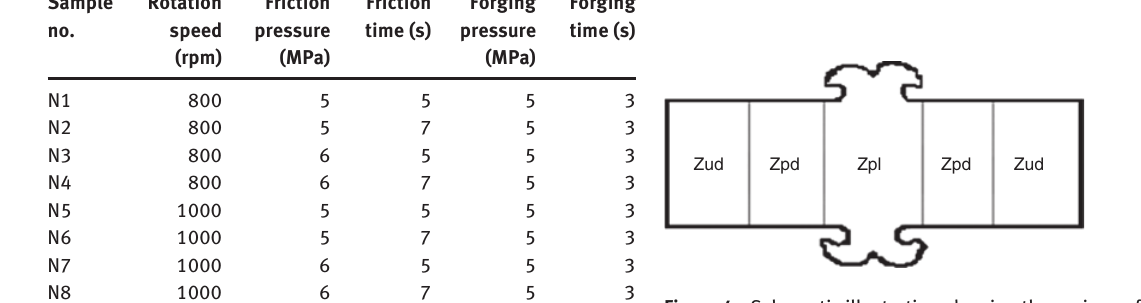
Figure 4 Schematic illustration showing the regions of the